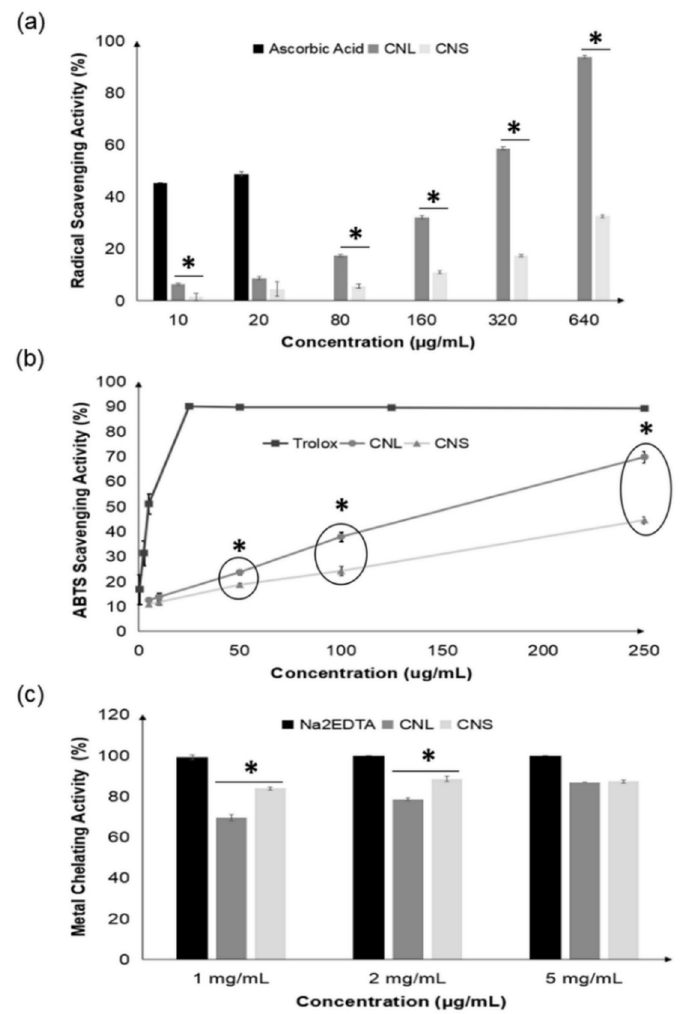
Figure 1. DPPH ( a ) and ABTS ( b ) radical scavenging and ferrous ion chelating ( c ) activities of CNL and CNS at various concentrations. All measurements were performed in triplicate and are expressed as mean ± standard deviation. The unpaired sample t -test was used to compare the variance of different datasets between CNL and CNS. Values with the symbol * are significantly different at p < 0.05. (CNL: Clinacanthus nutans leaf extract; CNS: Clinacanthus nutans stem